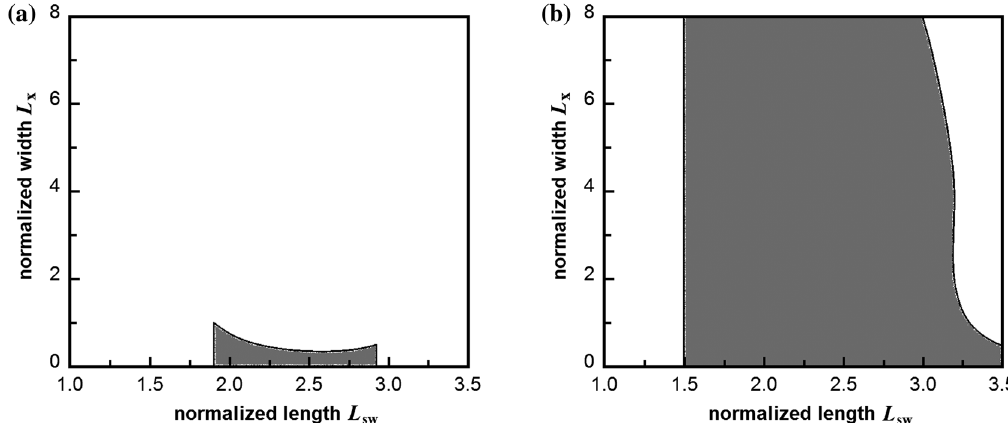
FIG. 5. The zone of establishment of the single-mode oscillation regime in the coaxial BWO (a) without and (b) with a 2D Bragg synchronizer.